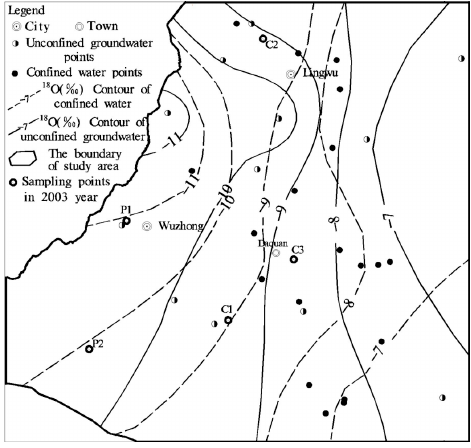
Figure 6. Contour lines of groundwater δ 18 O (‰).